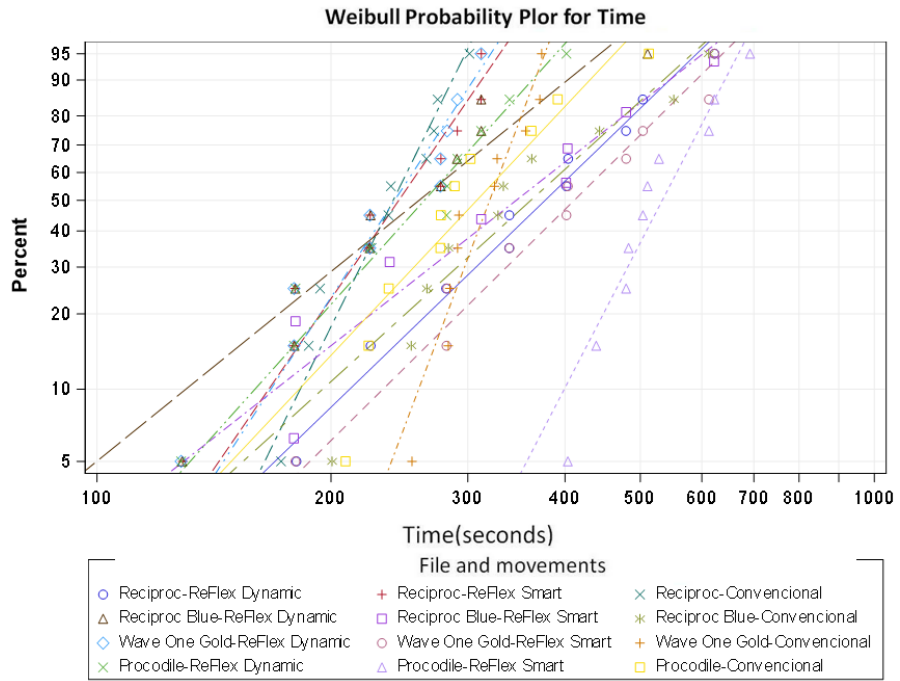
Figure 6. Weibull probability plot of the time to failure.